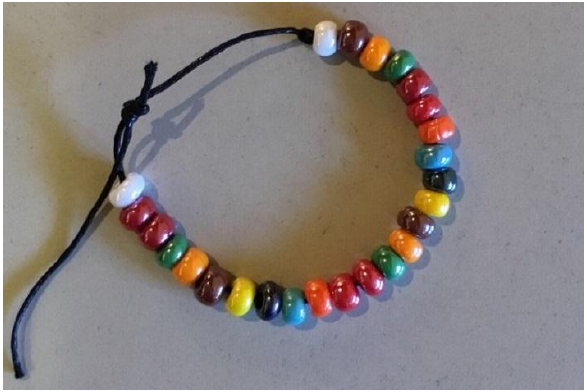
Figure 6. A bracelet built by one of the participants.